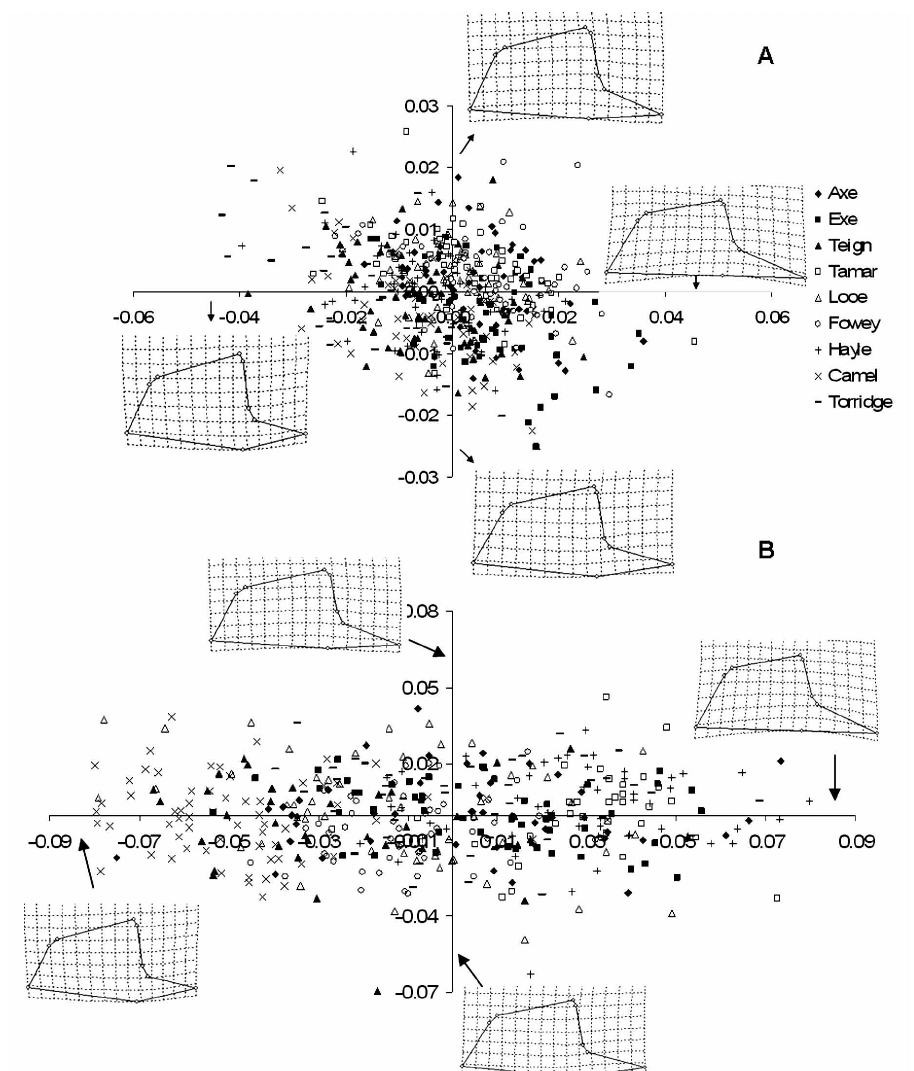
Fig . 5. – Scatterplot of individual scores from the relative warp analysis. Grids show deformation from consensus configuration of the major chela of Carcinus maenas males (A) and females